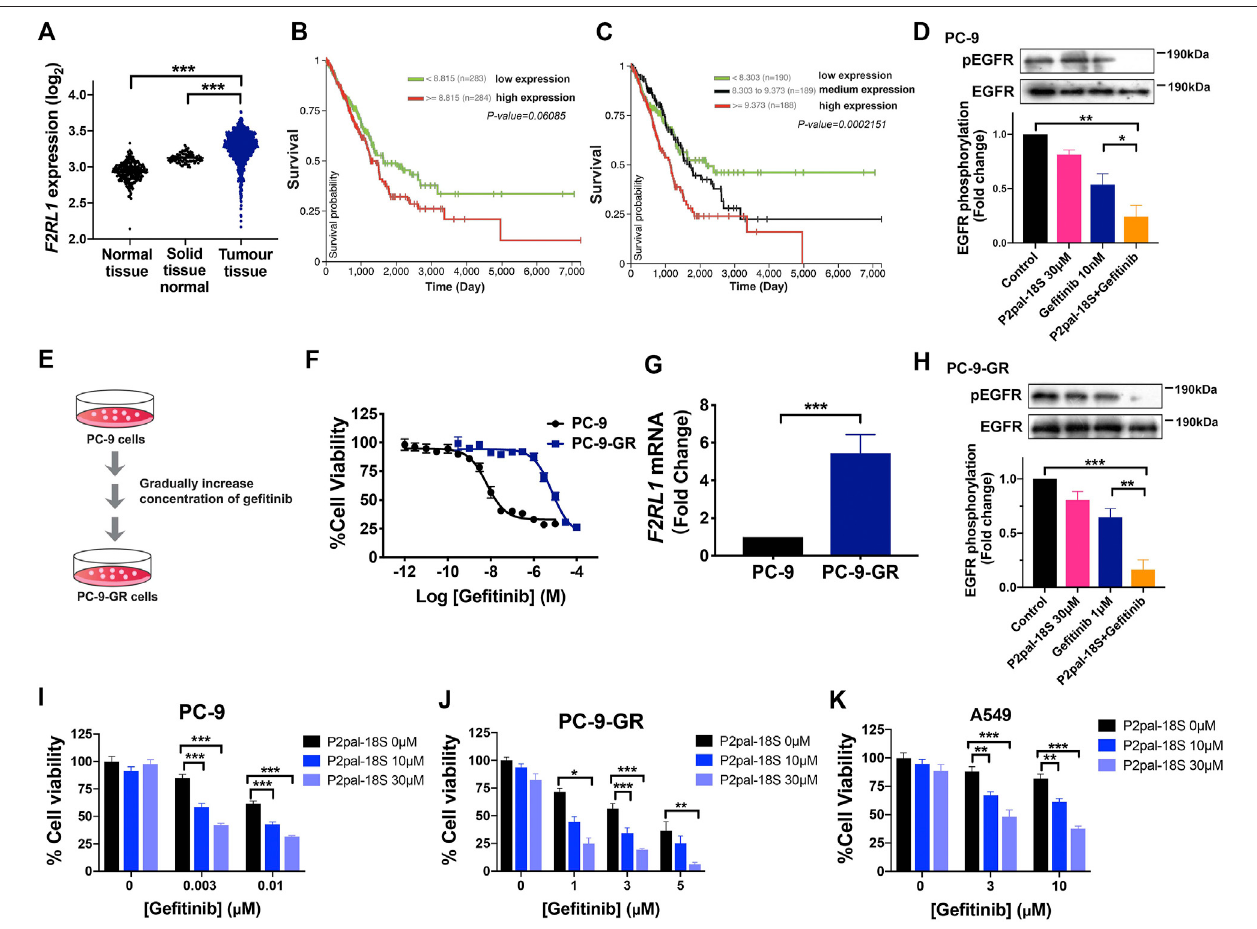
FIGURE 1 | PAR2 was associated with tumor progression while PAR2 inhibition overcame ge fi tinib resistance in NSCLCs. (A) PAR2 (F2RL1) expression in lung tumor tissues from TCGA database ( n (cid:1) 1,011) is higher than normal lung tissues from GTE X database ( n (cid:1) 288) or solid tissue normal samples from TCGA ( n (cid:1) 109); (B – C) .TheKaplan-MeiersurvivalanalysisofPAR2expressionsandTCGAlungadenocarcinoma(LUAD, n (cid:1) 576)usingUCSCXenaonlinetools; (D) .Thesynergiceffect of a PAR2 inhibitor (P2pal-18S, 30 μ M) and ge fi tinib (10 nM) in attenuating phosphorylation of EGFR in PC-9 cells; (E – F) . The ge fi tinib-resistant cells (PC-9-GR) wereconstructedandshowedmuchlesssensitivetoge fi tinibthanPC-9cells; (G) .PAR2(F2RL1)expressionwasincreasedinPC-9-GRcells; (H) .P2pal-18Spromoted ge fi tinib to inhibit phosphorylation of EGFR in PC-9-GR, detected by western blot. The densitometric analysis of each band was calculated with ImageJ software; (I – K) . Different concentrations of P2pal-18S augmented the growth inhibitory effect of ge fi tinib in PC-9 (I) , PC-9-GR (J) , A549 cells (K) . * p < 0.05, ** p < 0.01, *** p < 0.001.